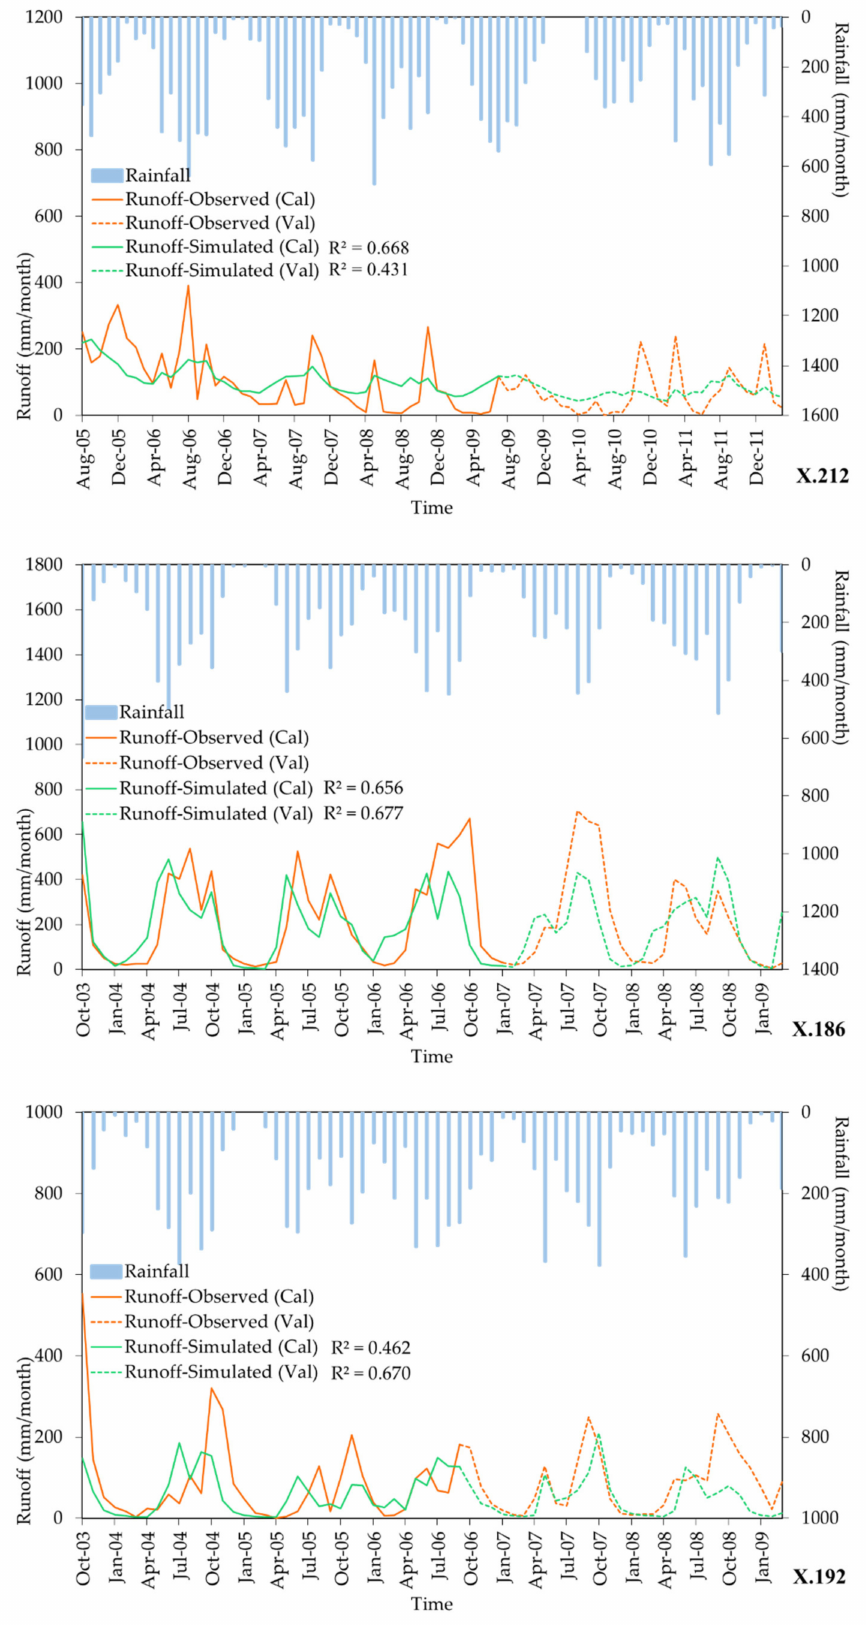
Figure 4. The relationship between rainfall and runoff of models (GR2M)